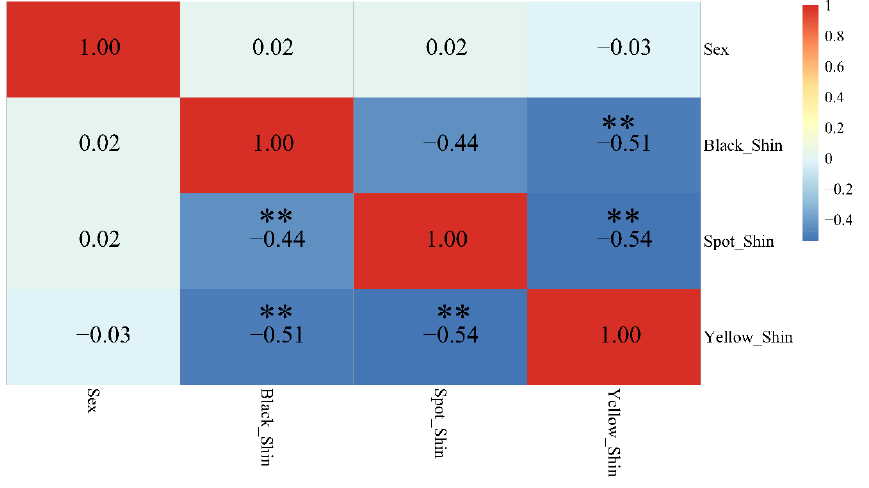
Figure 1. Correlation analysis of shin color and sex. ** represents p value ≤ 0.01.